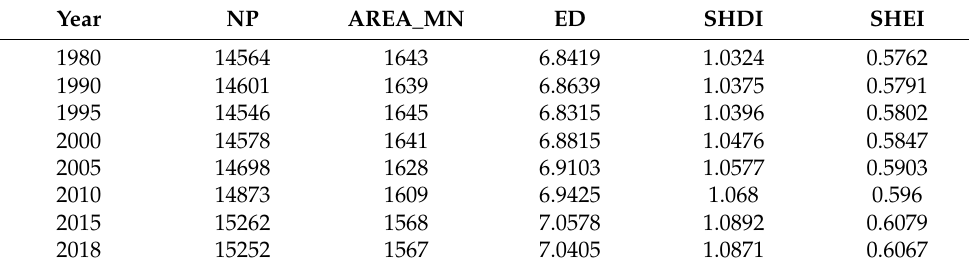
Table 4. Results of landscape pattern metrics at the landscape